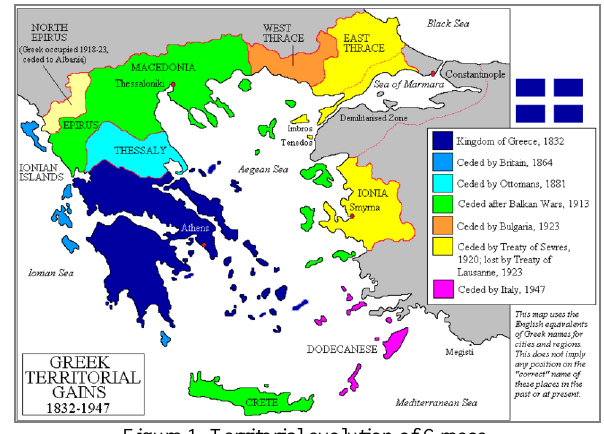
Figure 1. Territorial evolution of Greece